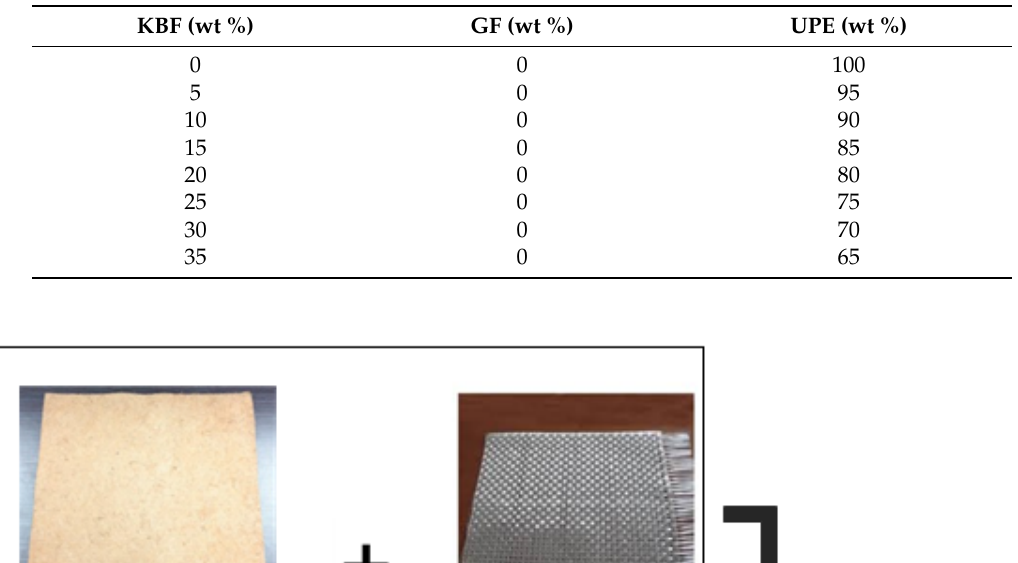
Table 1. Composition of KBF-reinforced UPE composites.